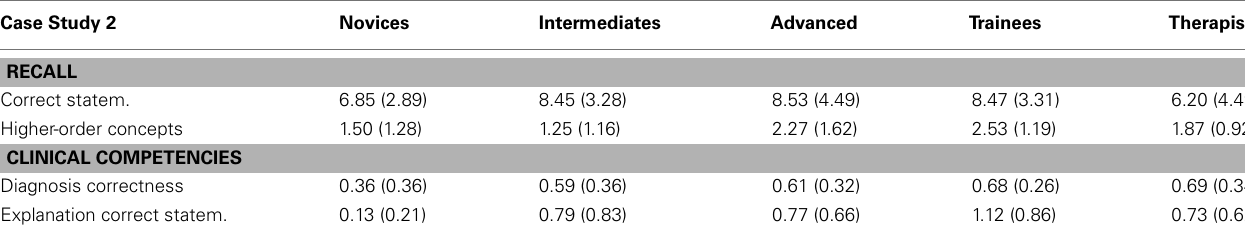
Table 3 | Means and standard deviations (in parentheses) for Case Study